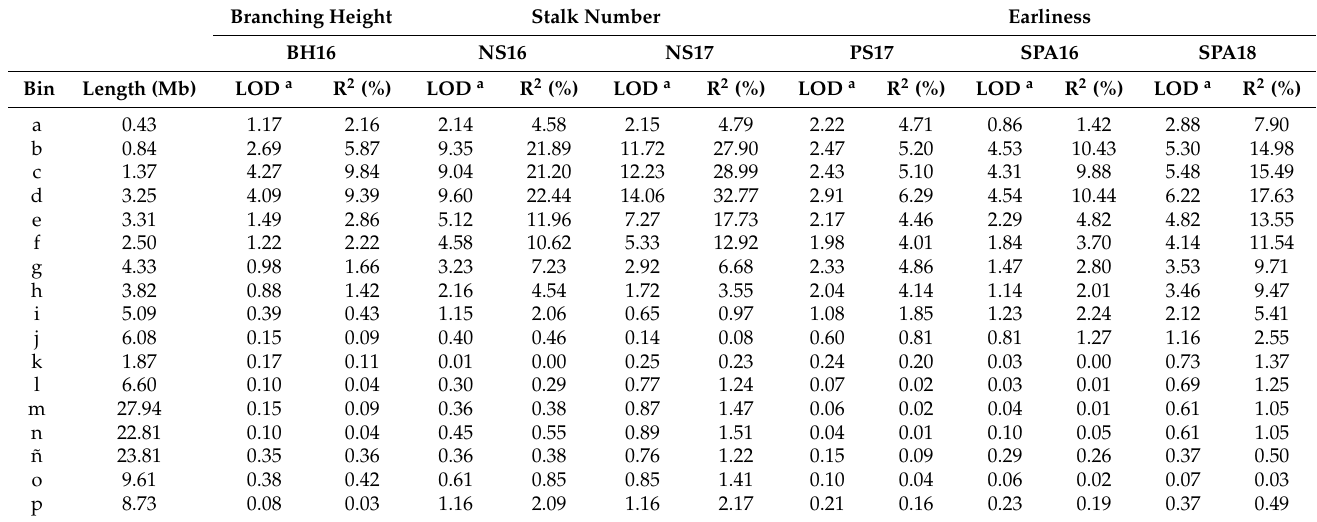
Table 3. Bins detected in chromosome 1 and QTLs identified. BH, mean branching height; NS, number of stalks; PS, phenological stage; SPA, spear area. The abbreviations of the trait names are followed by the year in which the trait was assessed (e.g., 16, 17, and 18 refer to the years 2016, 2017, and 2018,